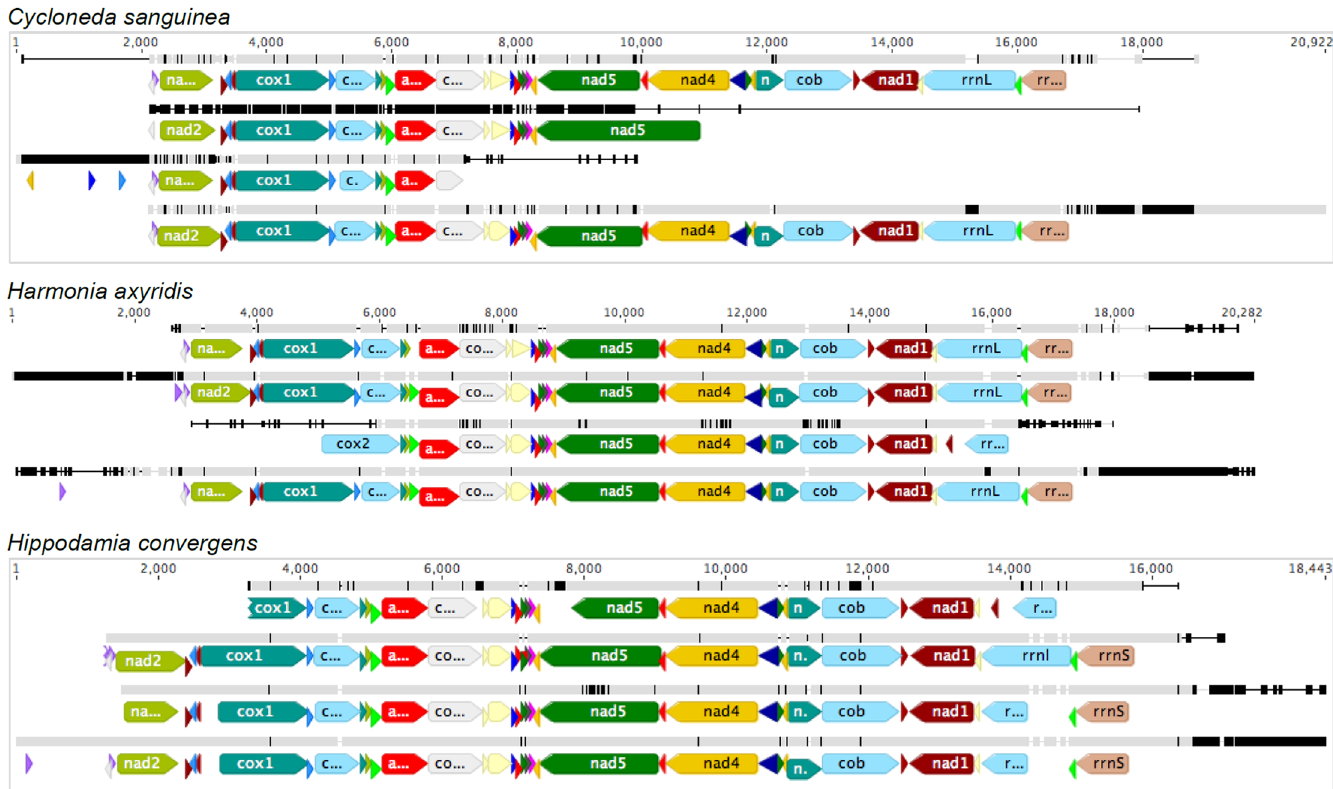
Fig 3. Alignment and comparison of the annotations and similarity of the mitogenomes of C . sanguinea , H . axyridis and Hi . convergens using the four methods. The annotated mitogenomes are in color, with arrows representingthe transcriptional sense of the gene, and small arrows representing tRNA genes. Grey bars represent similar nucleotides and vertical black bars represent dissimilarnucleotidesin the target sequencecomparedto the consensussequence,and horizontalblack lines representgaps in the target sequence.The four methods are displayedin order from the top for each